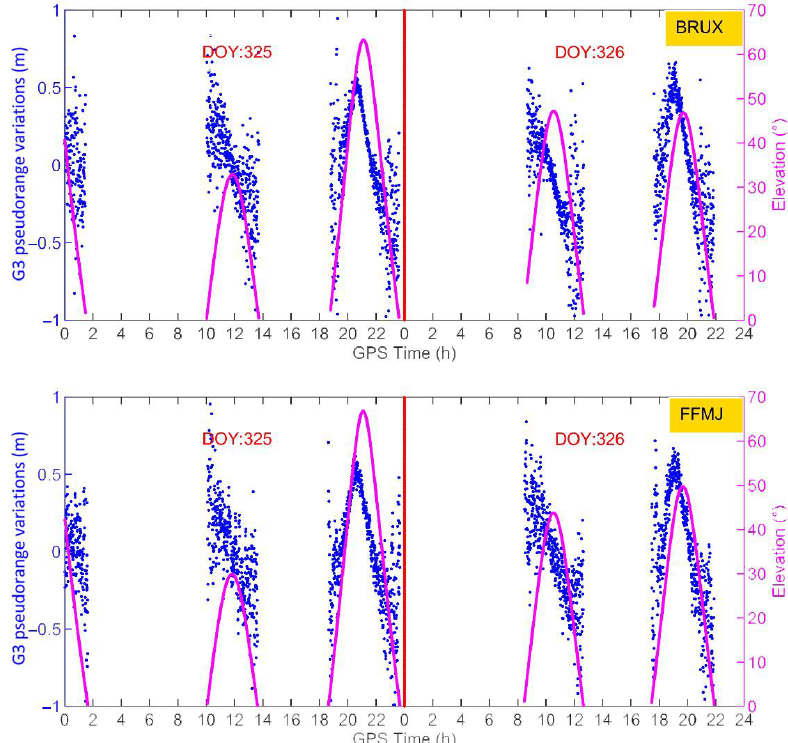
Figure 7. The code pseudorange variations of R21 on DOY 325 and 326, 2020, at BRUX station and FFMJ station. The blue dots denote the code pseudorange variations calculated by the CMC combination, the purple line denotes the elevation angle, and the vertical red line is the dividing line between DOY 325 and 326.